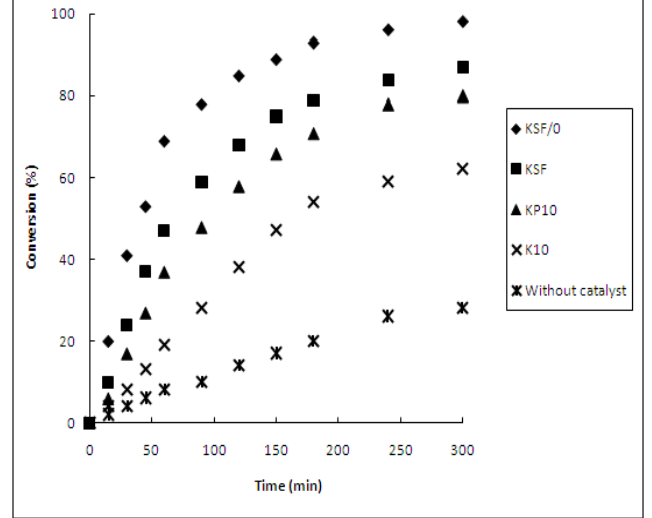
Figure 2. Conversion profiles of the esterification of stearic acid with ethanol over different acidic clay catalysts (T = 150 °C and 0.1